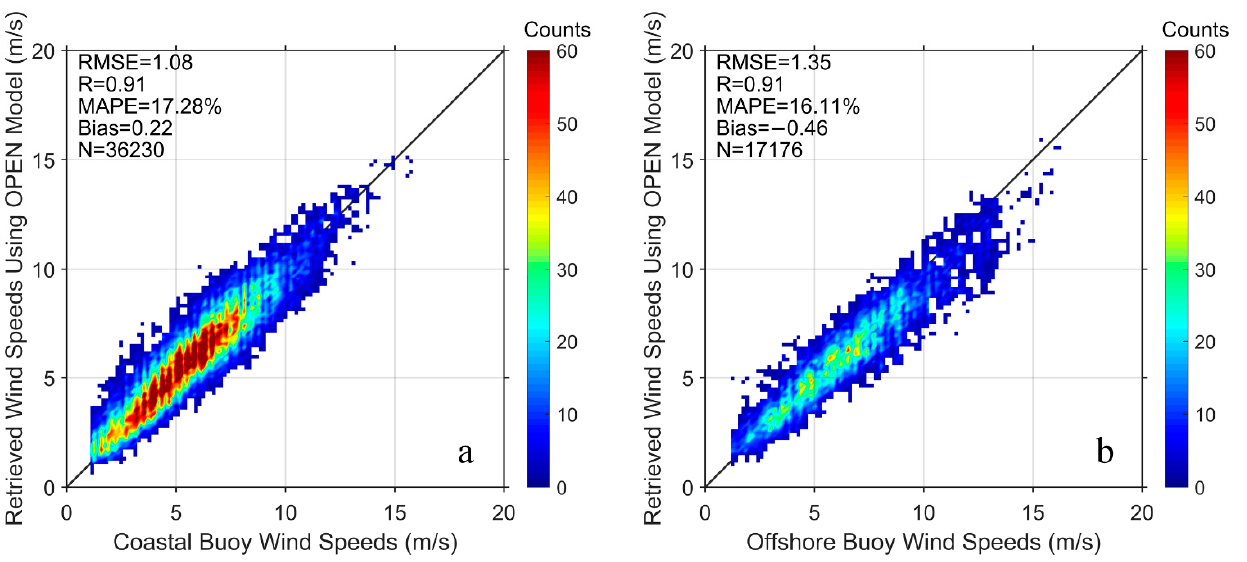
Figure 10. Comparisons of retrieved winds using the OPEN model divided into ( a ) Coastal and ( b ) Offshore buoy wind speeds.